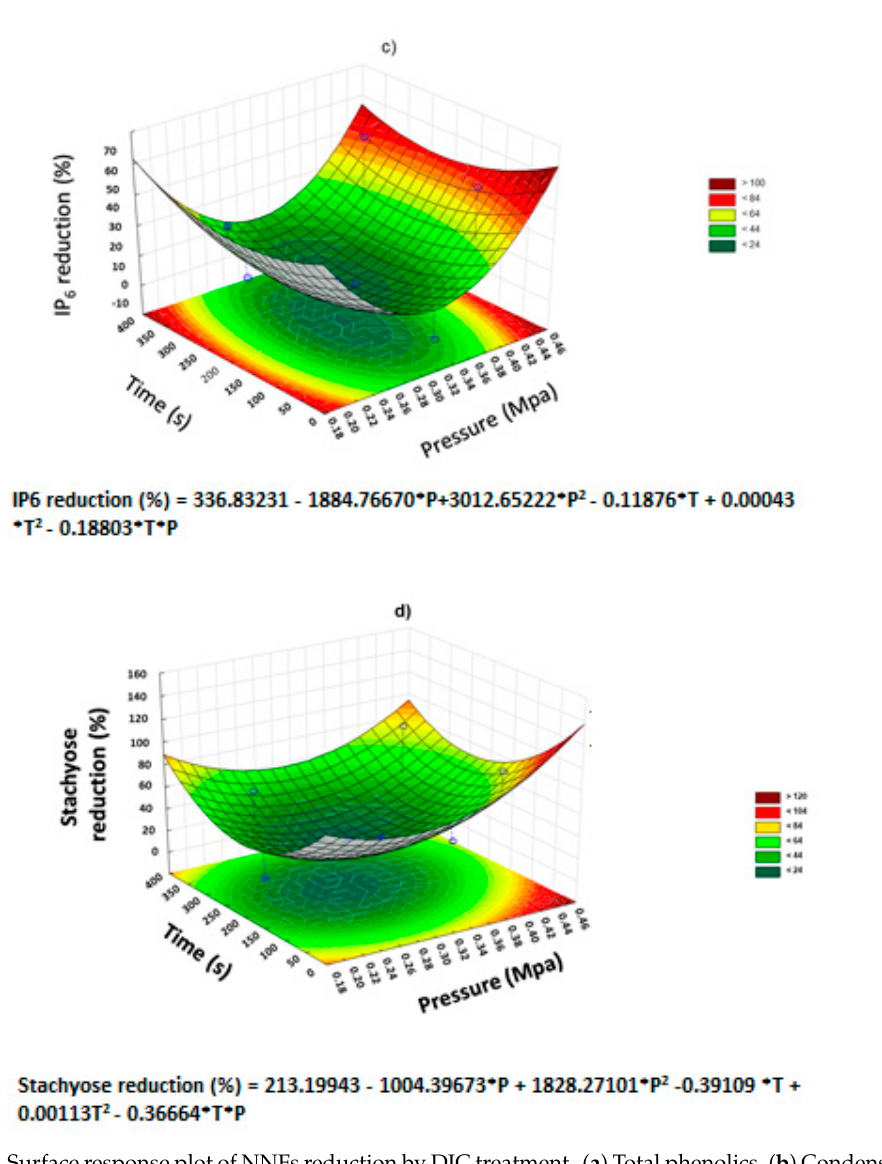
Figure 3. Surface response plot of NNFs reduction by DIC treatment. ( a ) Total phenolics, ( b ) Condensed tannins, ( c ) IP 6 , ( d ) Stachyose. P = pressure; T = Time.